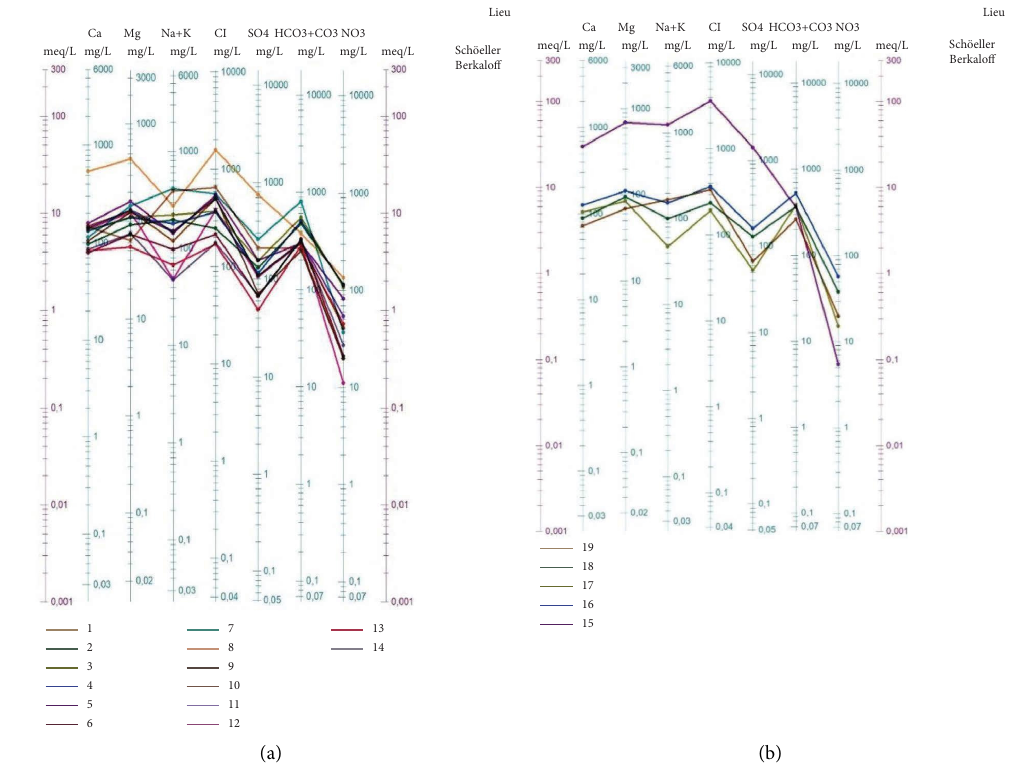
Figure 10: (a, b) Schoeller–Berkalof diagram of Angads groundwater in September 2020. Table 3: Te Moroccan food and irrigation standards and the WHO guidance values 2011. Physicochemical and bacteriological